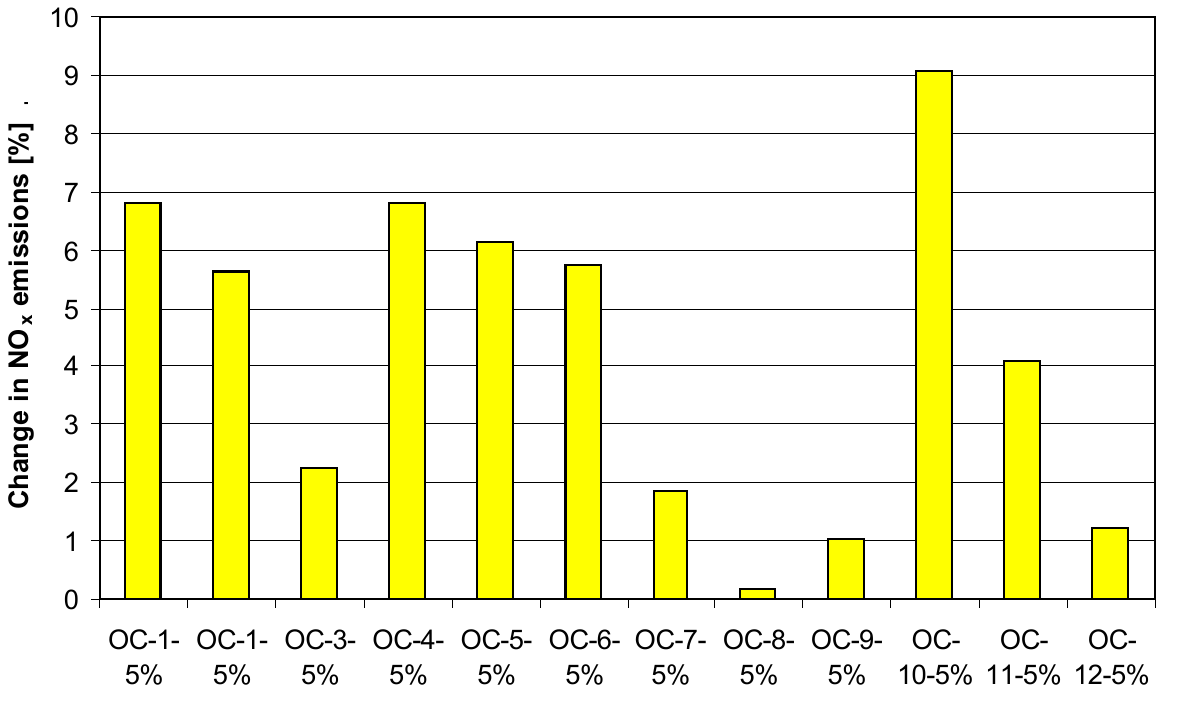
Figure A4. Percentage changes in HC emissions over the NEDC from a test car with fuels containing individual oxygenates at a concentration of 5% v / v compared to running on conventional diesel fuel.